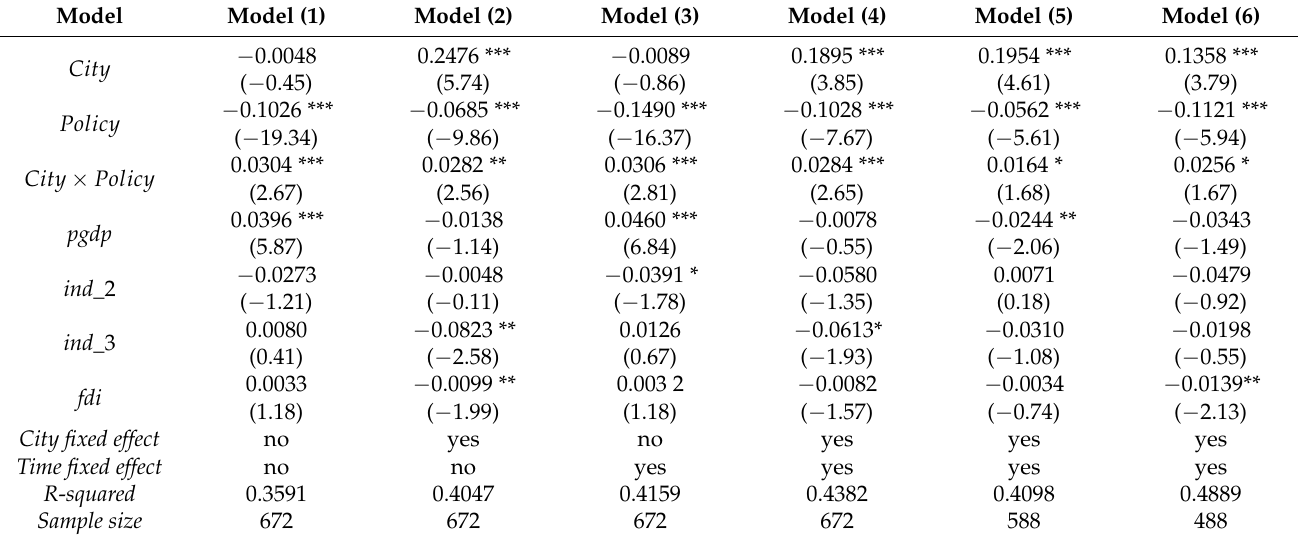
Table 2. Regression results of benchmark